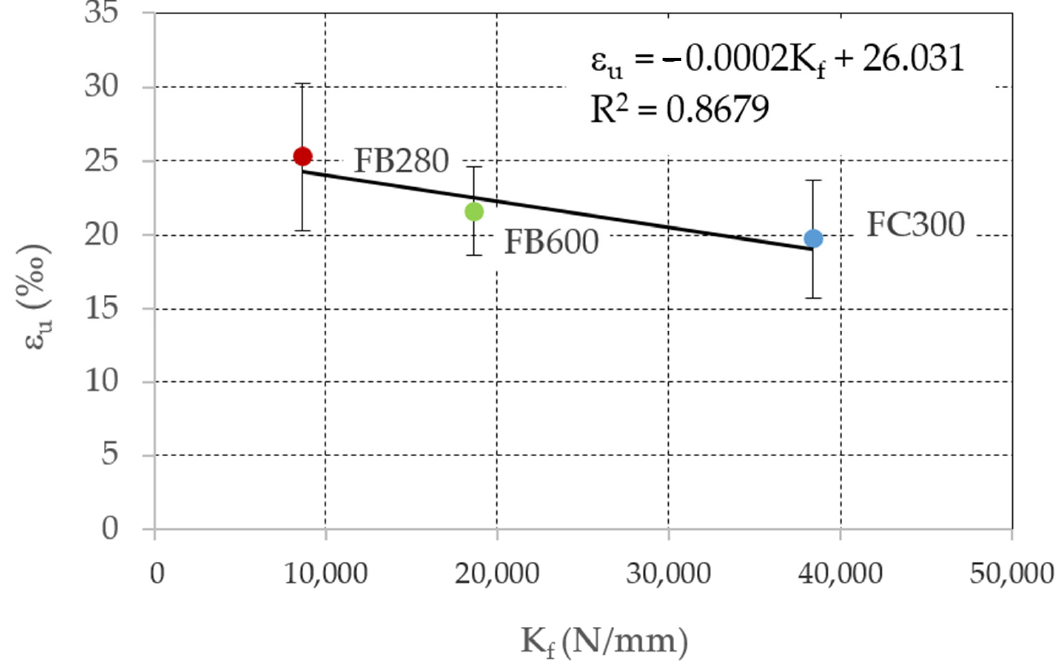
Figure 8. Relationship between the ultimate strain of the reinforced test pieces and the rigidity of the reinforcements.